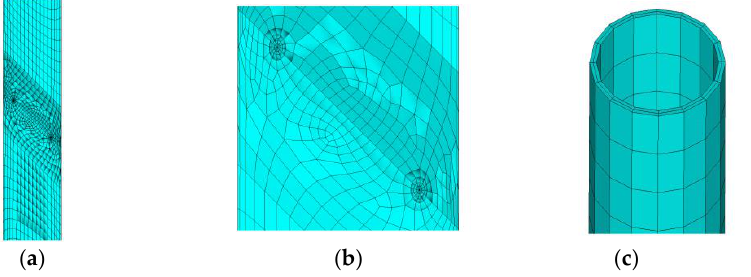
Figure 15. Finite element model of a thin-walled cylindrical shell model with an oblique crack. ( a ) Middle part of model, ( b ) Local area of model, ( c ) End region of model.